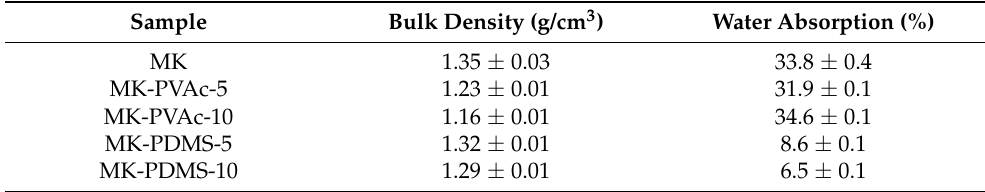
Table 4. Physical properties of the investigated samples: bulk density, water absorption, and total open porosity.